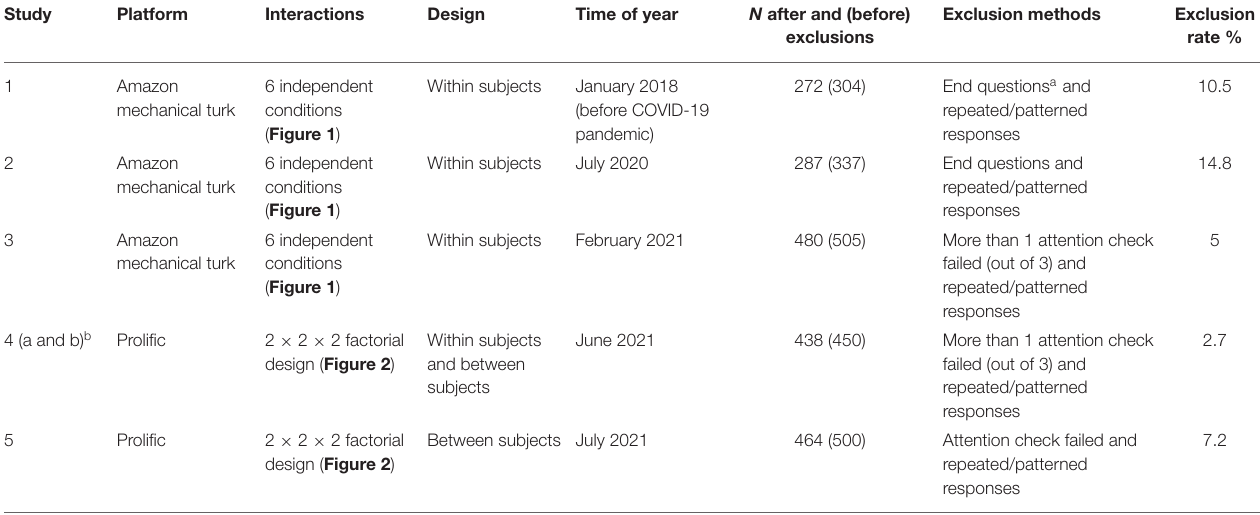
TABLE 1 | Overview of study